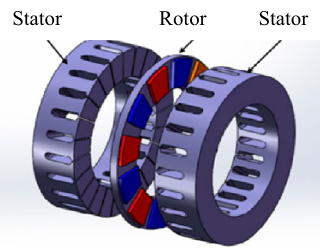
Stator StatorRotor